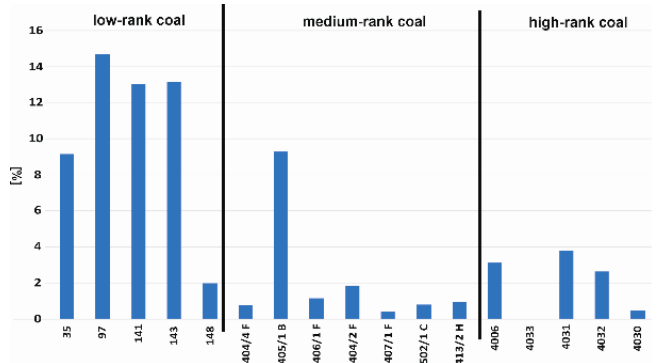
Figure 4. Mineral matter content in samples of various metamorphism degrees.